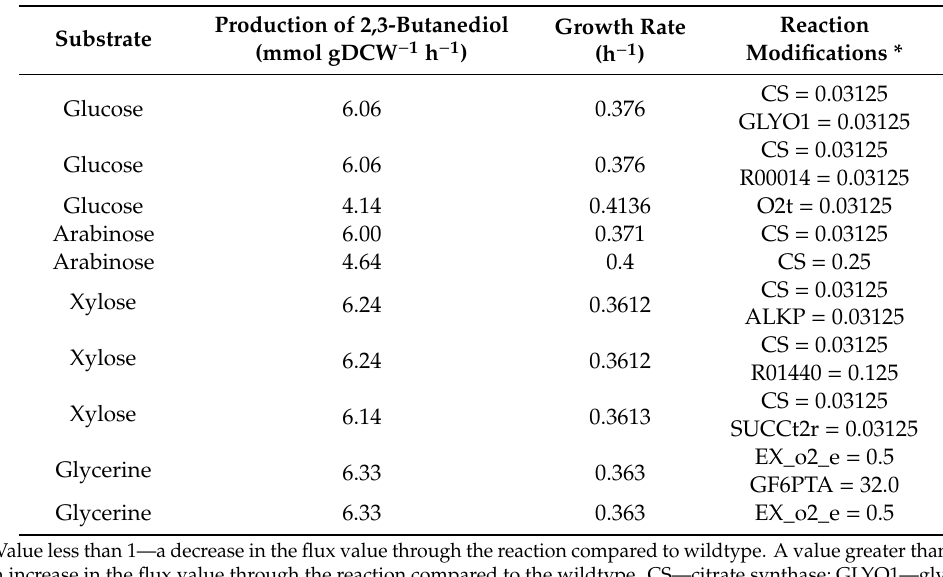
Table 3. The most e ff ective optimization results of iMK1321 model for 2,3-butanediol production with the Linear implementation of Minimization Of Metabolic Adjustment (LMOMA)